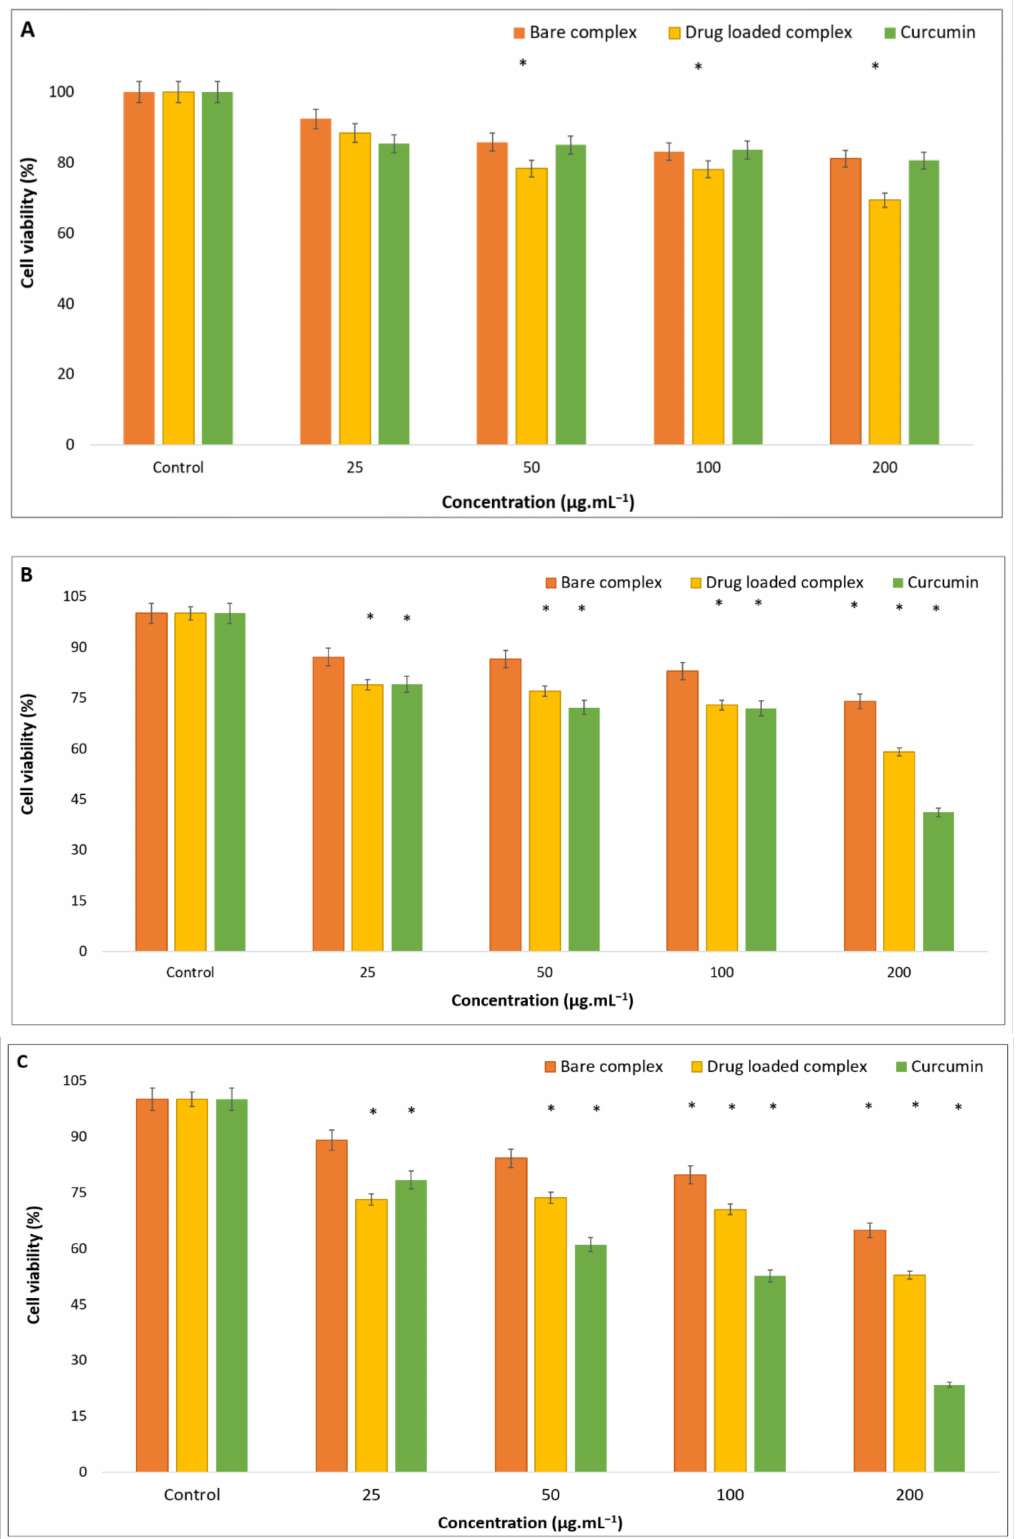
Figure 5. The results of the MTT assay test of different formulations after 24 h ( A ), 48 h ( B ), and 72 h ( C ) exposure with the A549 cancer cell line (* indicates p ≤